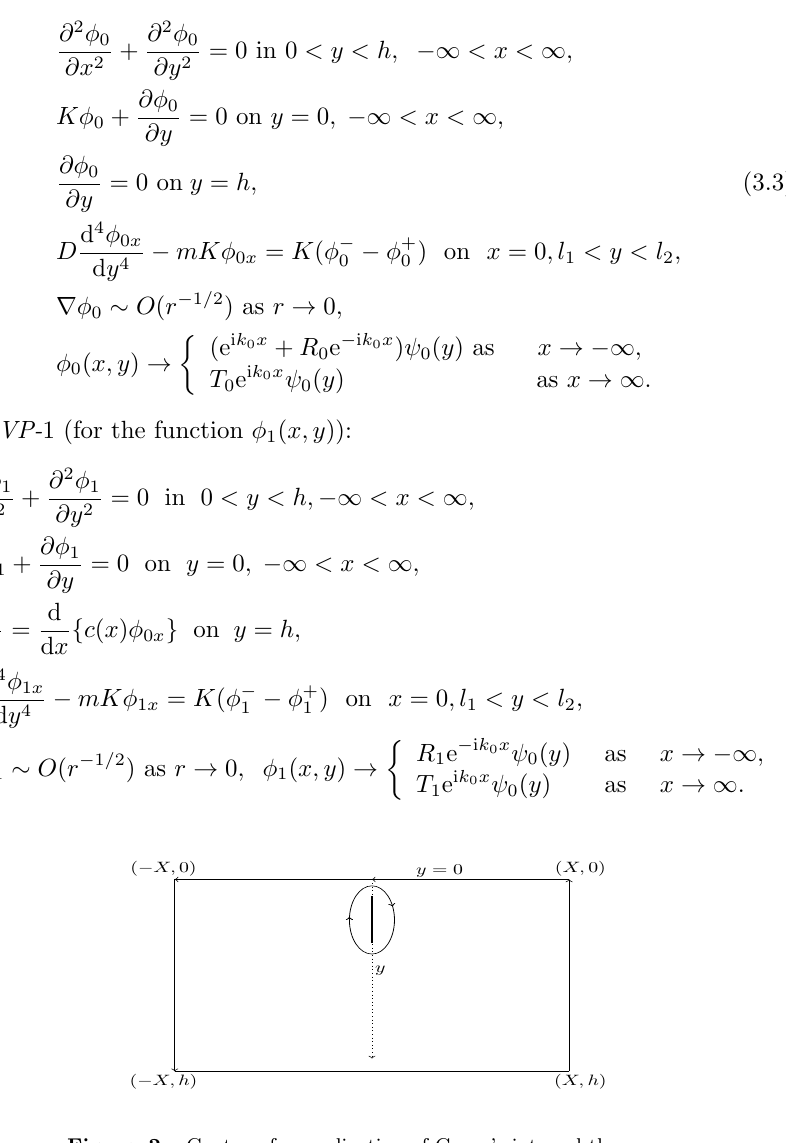
Figure 2. Contour for application of Green’s integral